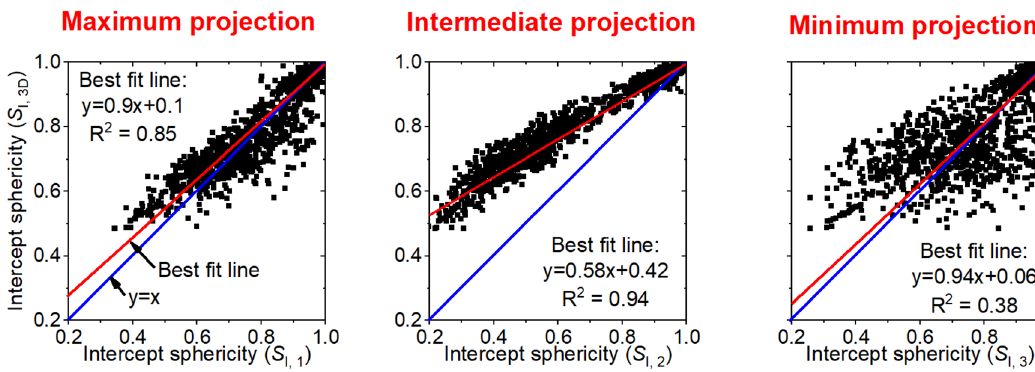
Fig. 11 Relationships between 2D vs. 3D intercept sphericity